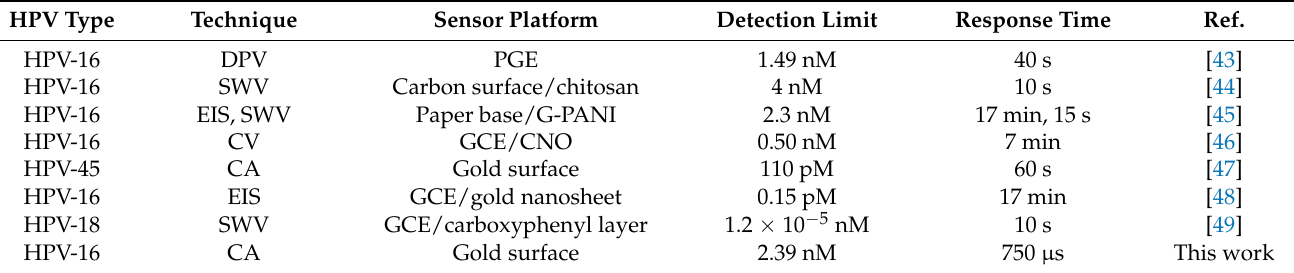
Table 2. Comparison of electrochemical DNA biosensors for